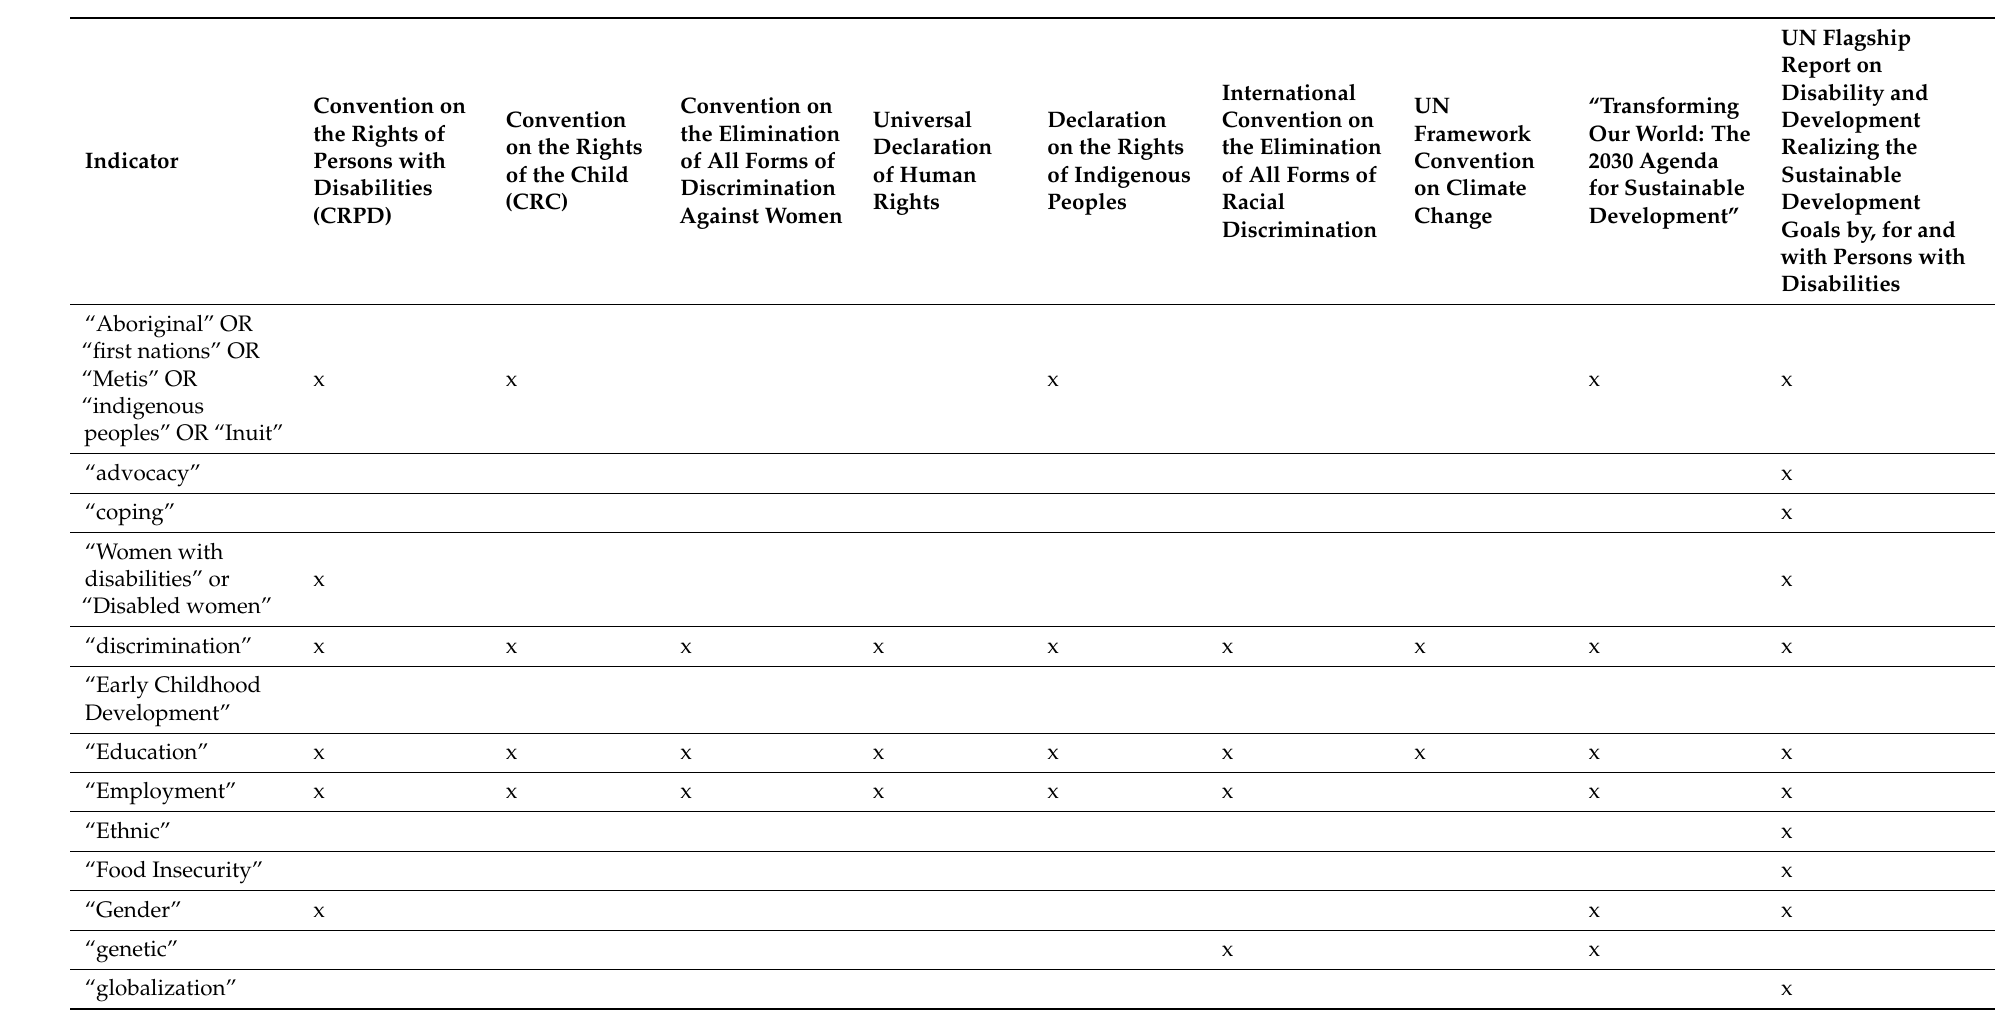
Table 8. Presence of Social determinants of health (SDH) indicators in the actual document such as the